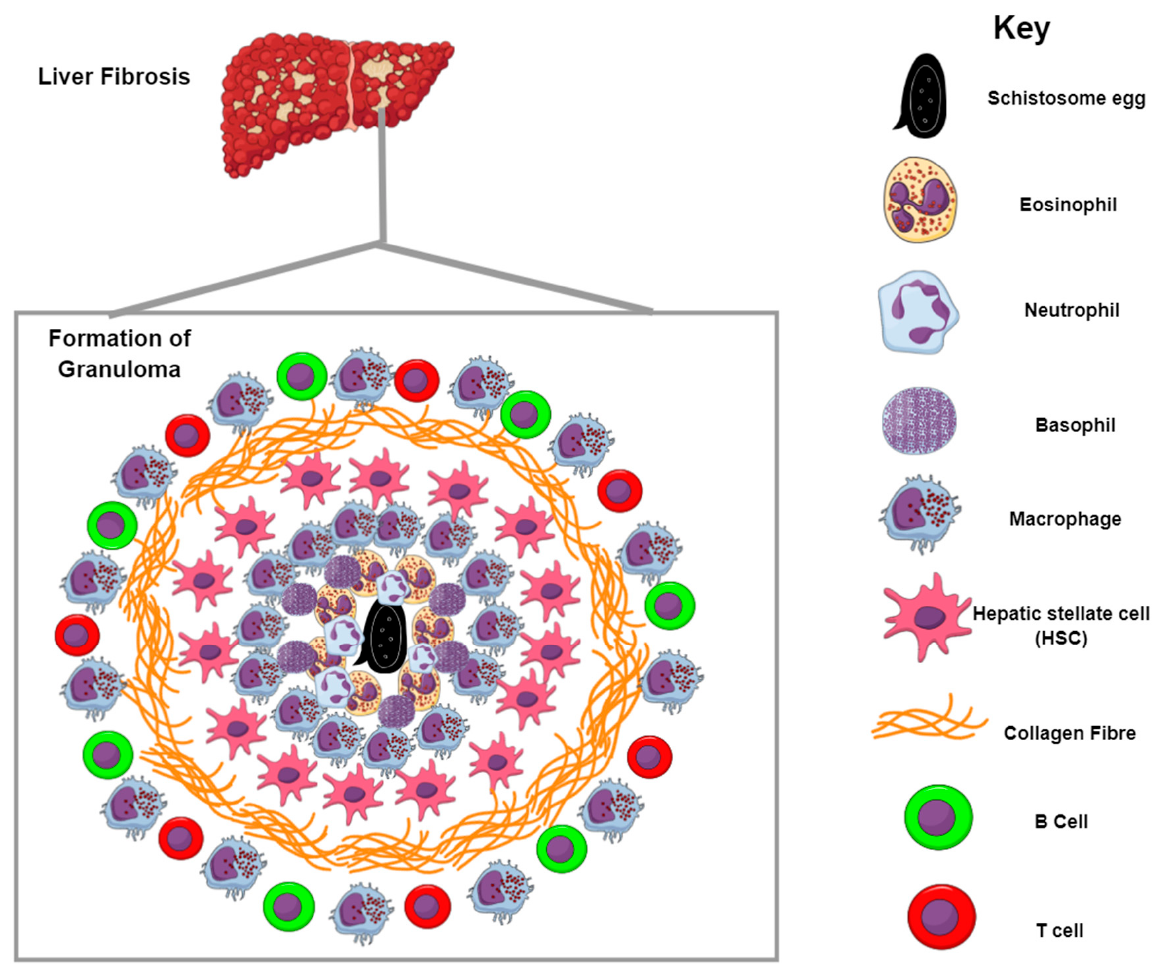
Figure 3. Formation of the granuloma and liver fibrosis. Granulomas are formed by the recruitment of inflammatory cells to the site of infection. Schistosome eggs release SEA that trigger the generation of antibodies, which recruit inflammatory cells mostly in the form of macrophages and eosinophils around the eggs. Neutrophils and basophils can also be seen during the initial phase of granuloma formation. The contents of the granuloma are bound by collagen fibers whose production is largely driven by IL-13; this subsequently results in liver fibrosis.